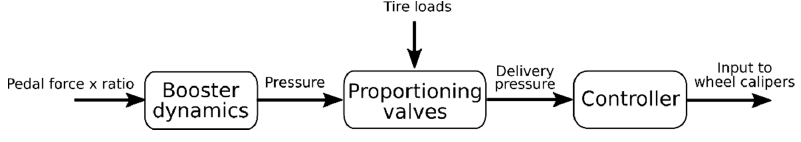
Figure 2. Basic scheme of the vehicle brake system.